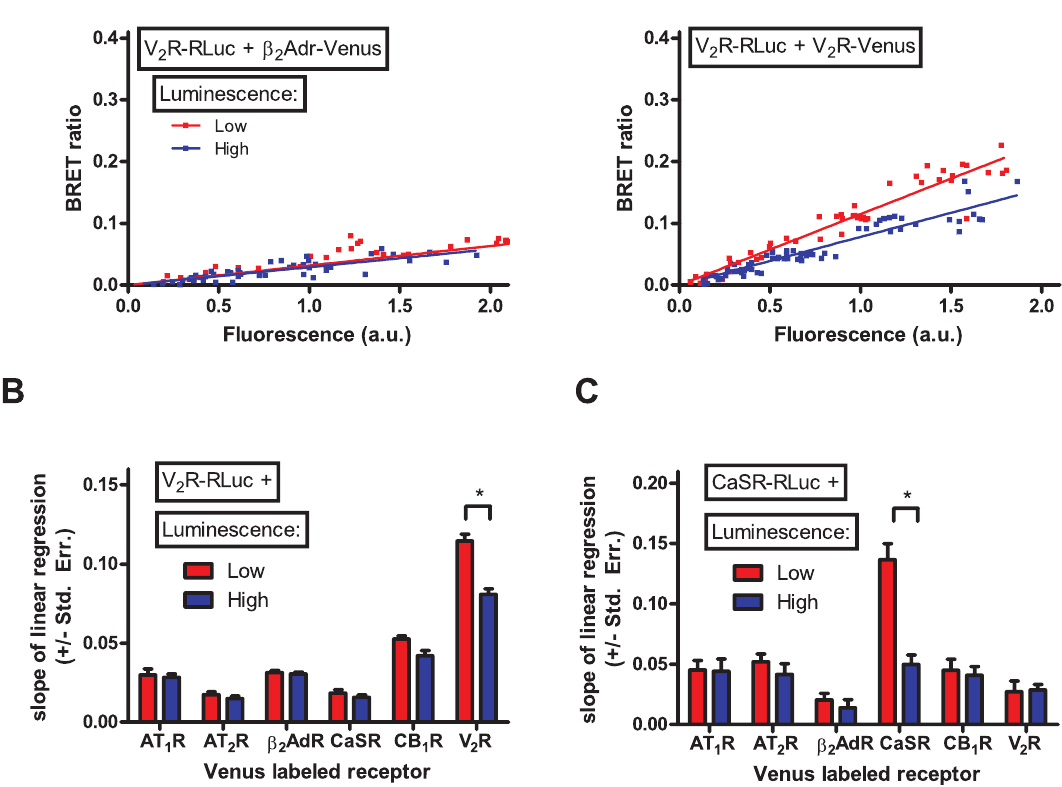
Figure 4. Dimerization of V 2 vasopressin receptor and CaSR calcium sensing receptor with various other GPCRs. HEK293 cells were transiently transfected with increasing amounts of V 2 R-RLuc (A and B) or CaSR-RLuc (C) and with increasing amounts of either AT 1 R-Venus, AT 2 R- Venus, b 2 AdR-Venus, CaSR-Venus, CB 1 R-Venus or V 2 R-Venus. Various amounts of empty pcDNA3.1 plasmid was added to maintain constant total transfected plasmid amount. Total luminescence and Venus fluorescence were measured at the beginning of each experiment. BRET ratio was calculated as Emission 530 /Emission 485 , and was plotted as a function of measured fluorescence. (A) Representative Type I plots for V 2 R- b 2 AdR interaction (left plot) and V 2 R-V 2 R interaction (right plot). Measured points were sorted into low/high luminescence groups based on the total measured luminescence (Figure S2). (B and C) The slope of linear regression was calculated for the low and high luminescence groups of different GPCR pairs, and was plotted as a column diagram. Difference between the slopes of linear regression was determined by ANCOVA.